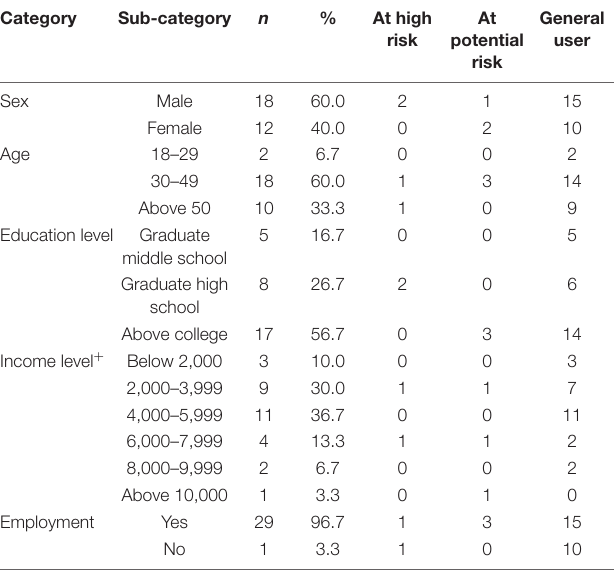
TABLE 1 | General characteristics of people with visual